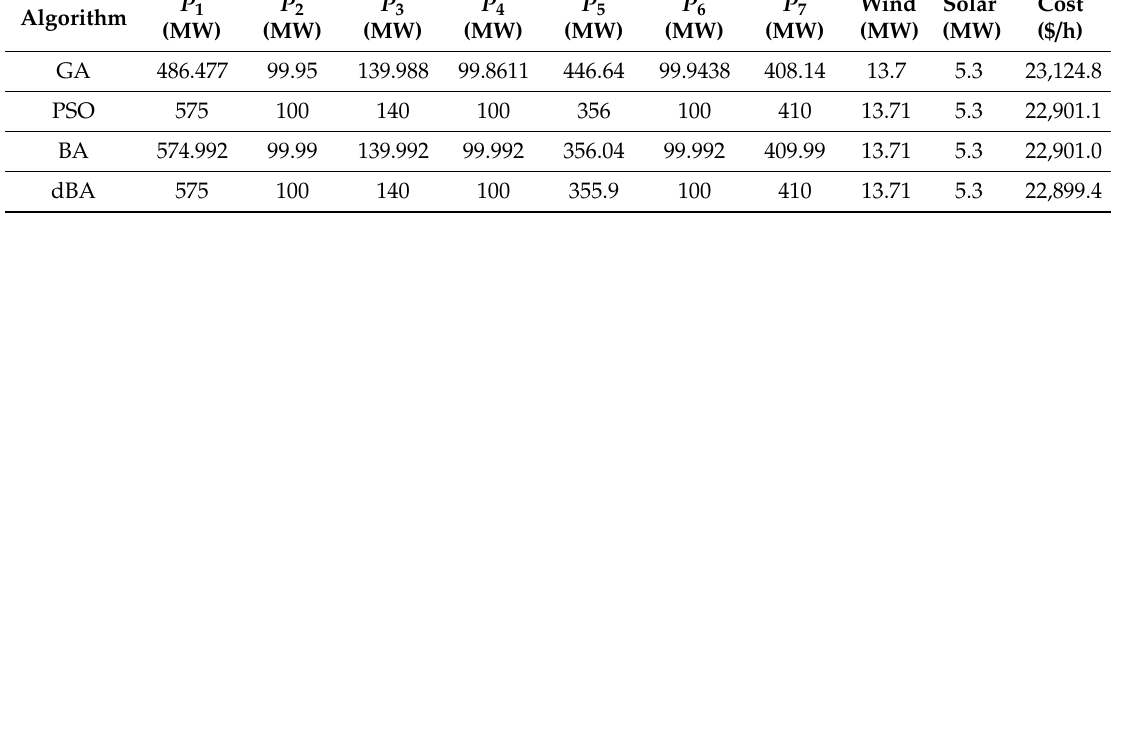
Figure 9. The loudness of the best bat of the BA and dBA.